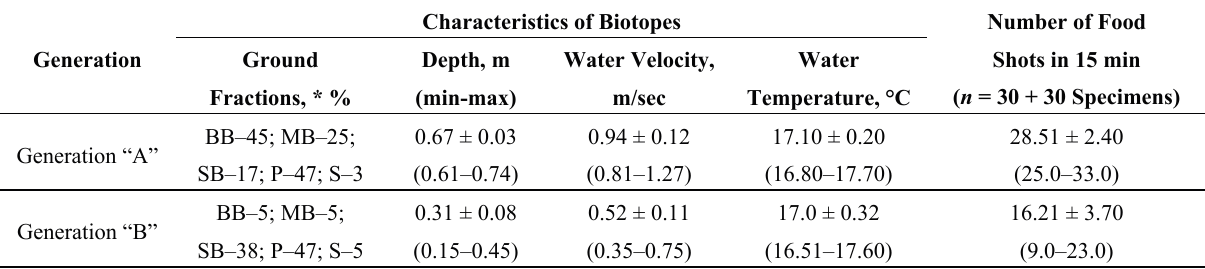
Table 1. Characteristics of the biotopes and food shot intensities of juvenile fish from the two